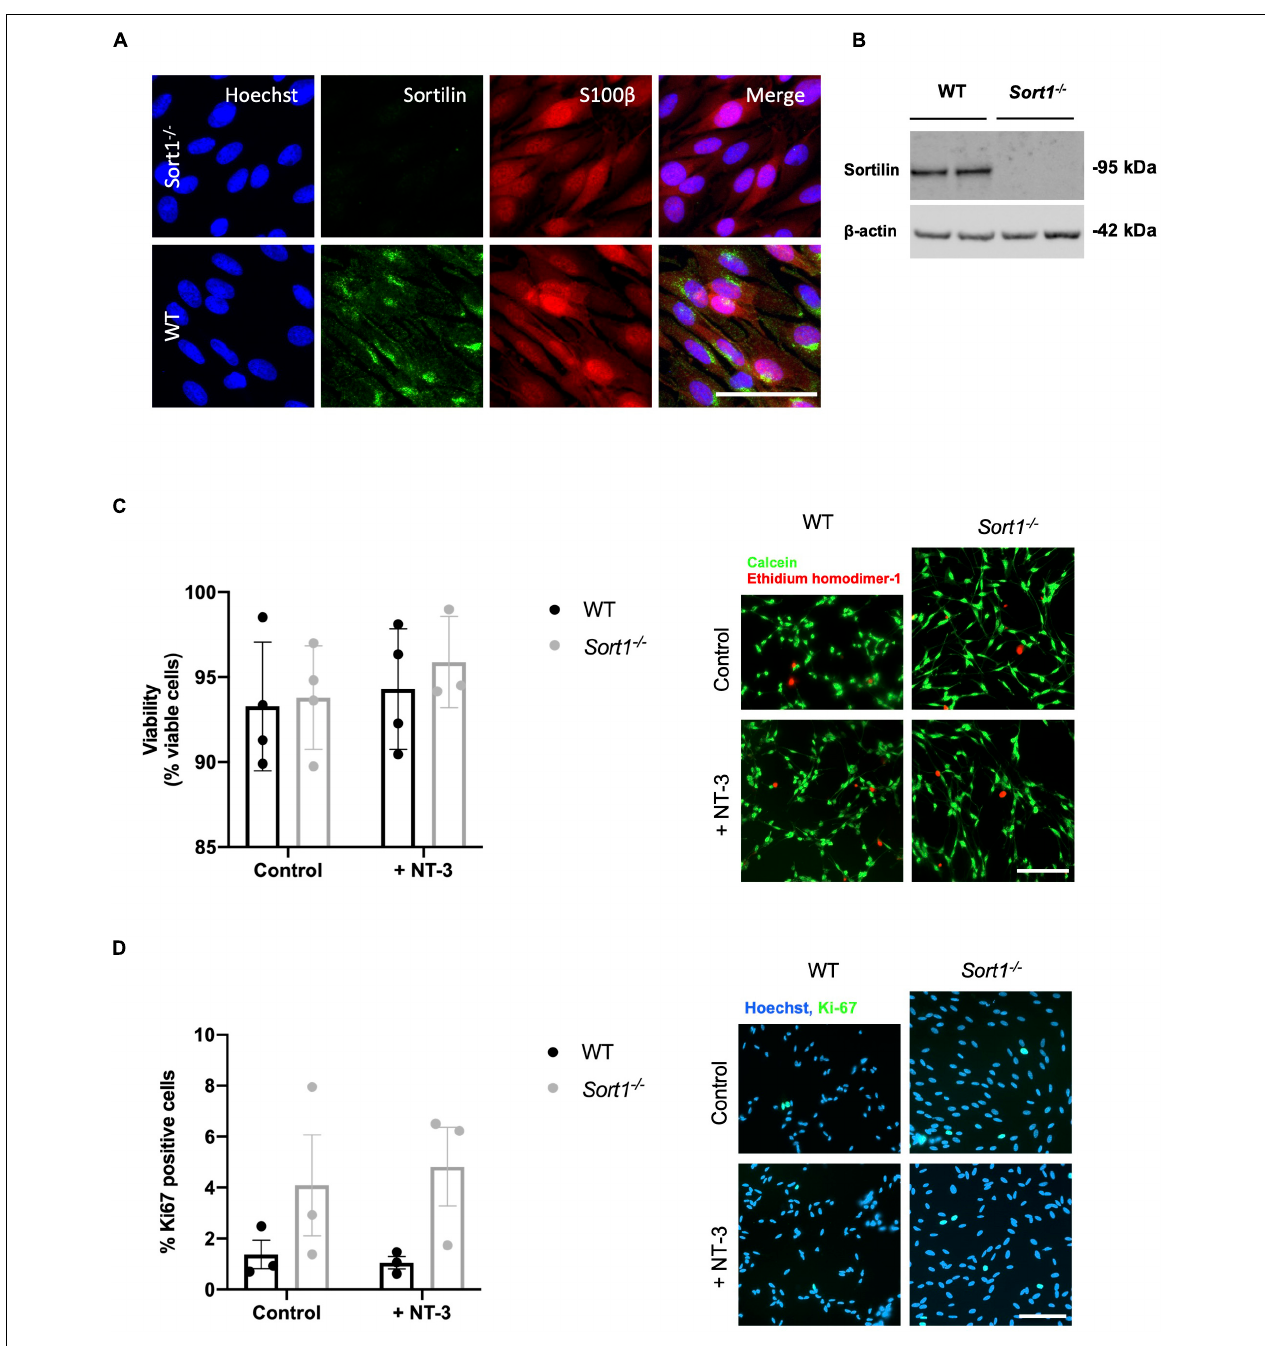
FIGURE 5 | Primary cultured Schwann cells express sortilin. (A) Double-labeled immunofluorescence microscopy of primary cultured Schwann cells show sortilin (green) in wild-type (WT) Schwann cells (red; identified by the Schwann cell marker s100 β ), but not in cells derived from Sort1 − / − rat sciatic nerves. Nuclei are labeled with Hoechst (blue). Scale bar 50 µ m. (B) Immunoblot analysis of sortilin in lysates of WT or Sort1 − / − primary Schwann cells shows sortilin expression in WT. (C) The viability of Sort1 − / − Schwann cells is like WT Schwann cells with (95.89 ± 1.55% vs. 94.30 ± 1.77%, p > 0.99) or without NT-3 stimulation (93.8 ± 1.52% vs. 93.29 ± 1.89%, p > 0.99). Viable cells were identified in Schwann cell cultures 24 h after stimulation with or without NT-3 by calcein (green) fluorescence, while dead cells were identified by ethidium homodimer-1 (red) fluorescence. Scale bar 100 µ m. Viability reflects mean% calcein-positive cells ± SEM, n = 4. (D) Schwann cell proliferation (percentage of Ki-67% cells) was not significantly different in cultures of Sort1 − / − Schwann cells compared to WT Schwann cell cultures with (4.82 ± 1.54% vs. 1.05 ± 0.25%, p = 0.4381) or without NT-3 stimulation (4.09 ± 1.98% vs. 1.37 ± 0.56%, p > 0.99). The proliferation marker, Ki-67 (green), was identified by immunofluorescence in Schwann cell cultures 48 h after stimulation with or without NT-3. Nuclei are labeled with Hoechst (blue). Scale bar 100 µ m. Proliferation rates reflect% Ki-67 positive cells ± S.E.M., n = 3. Statistical significance was analyzed using two-way ANOVA with Bonferroni’s multiple comparisons post hoc